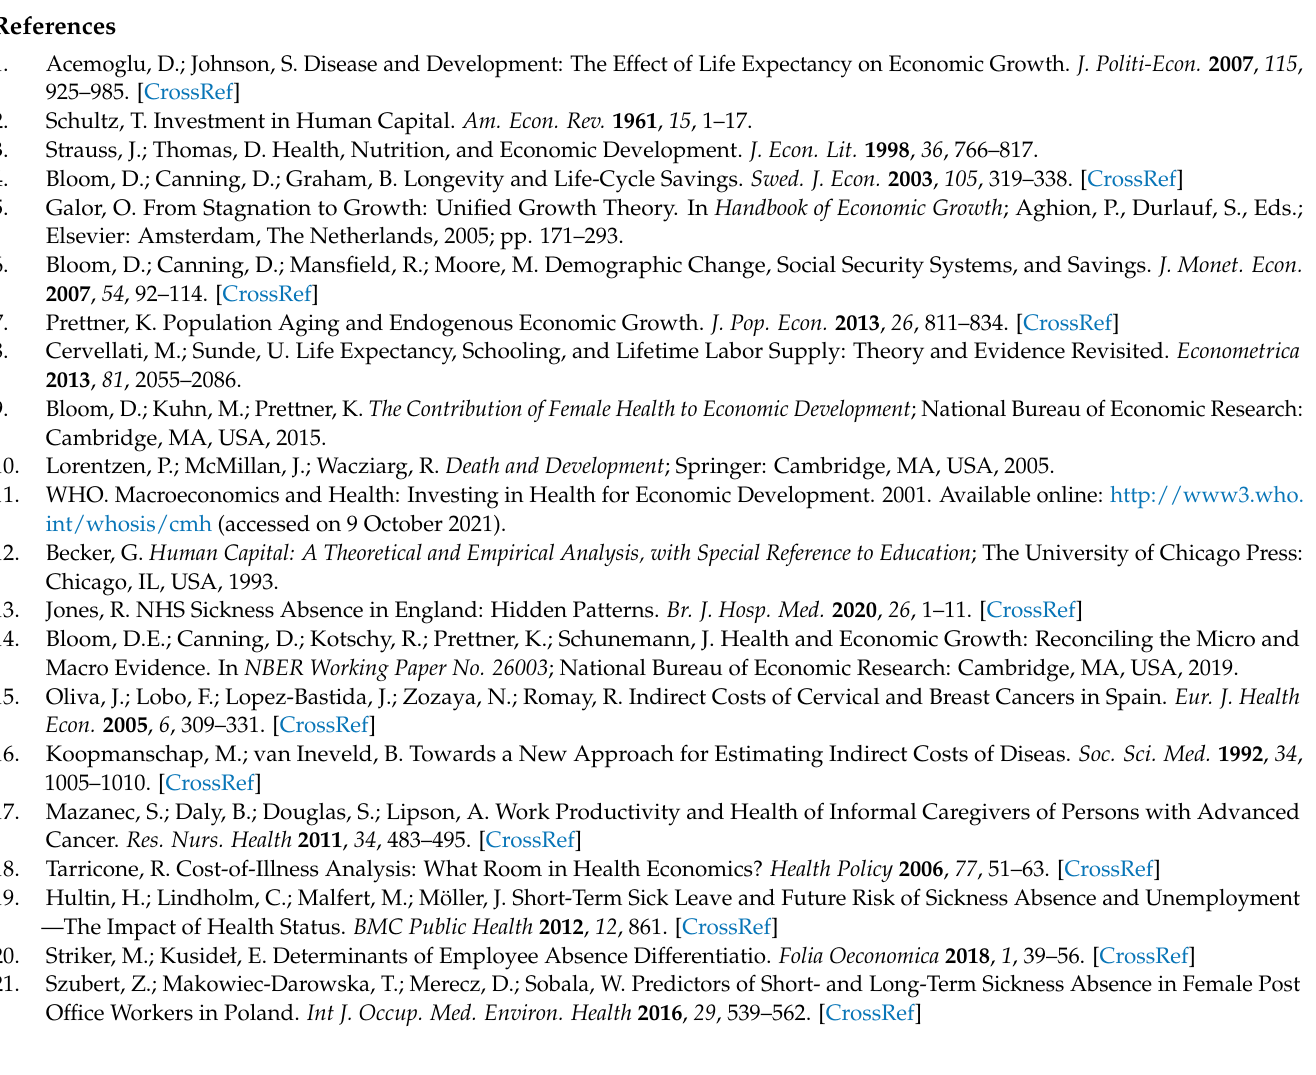
Figure A1. The local spatial autocorrelation of the absence rates for ( a ) men in 2006, ( b ) women in 2020, ( c ) men in 2020, and ( d ) women in 2020. Note: We used the same threshold distance spatial matrix (as in the global Moran’s I). A comprehensive spatial weighting scheme year-by-year for LISA (local indicators of spatial association) is available on request.